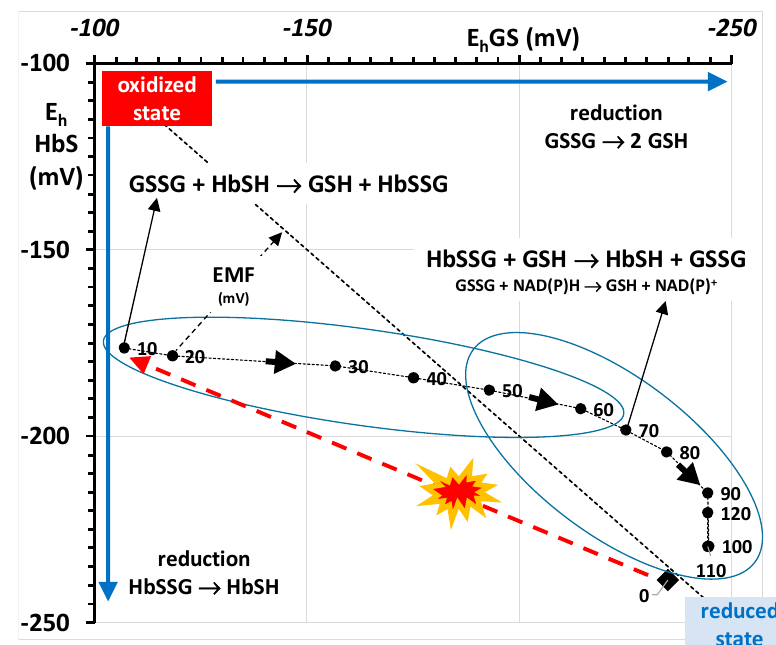
Figure 5. Plot of the respective values of the E h potentials of the two redox couples at the different times during the RBC oxidative challenge experiment. Shown are the values of the E h at the respective times (closed circles, time in min, numbers close to the closed circles, time flow identified by the linking line and the closed arrows).